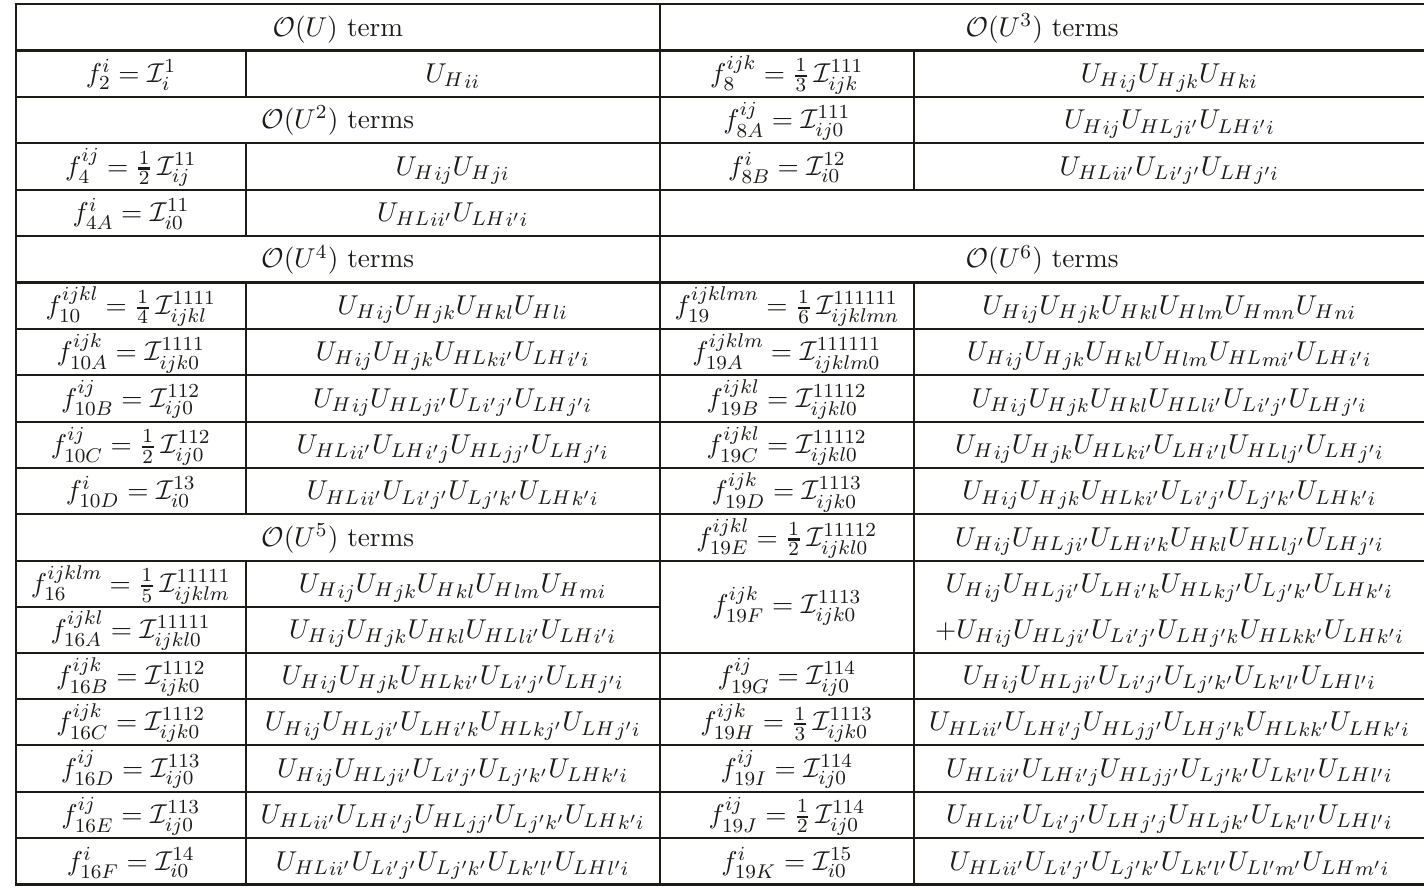
Table 5 . Universal coefficients for operators involving only U . There are 30